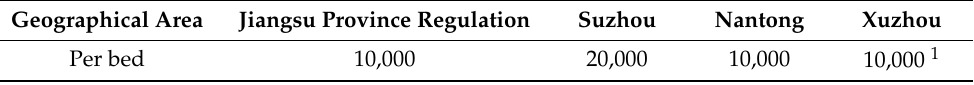
Table 3. Differences in construction subsidies in selected regions (yuan).